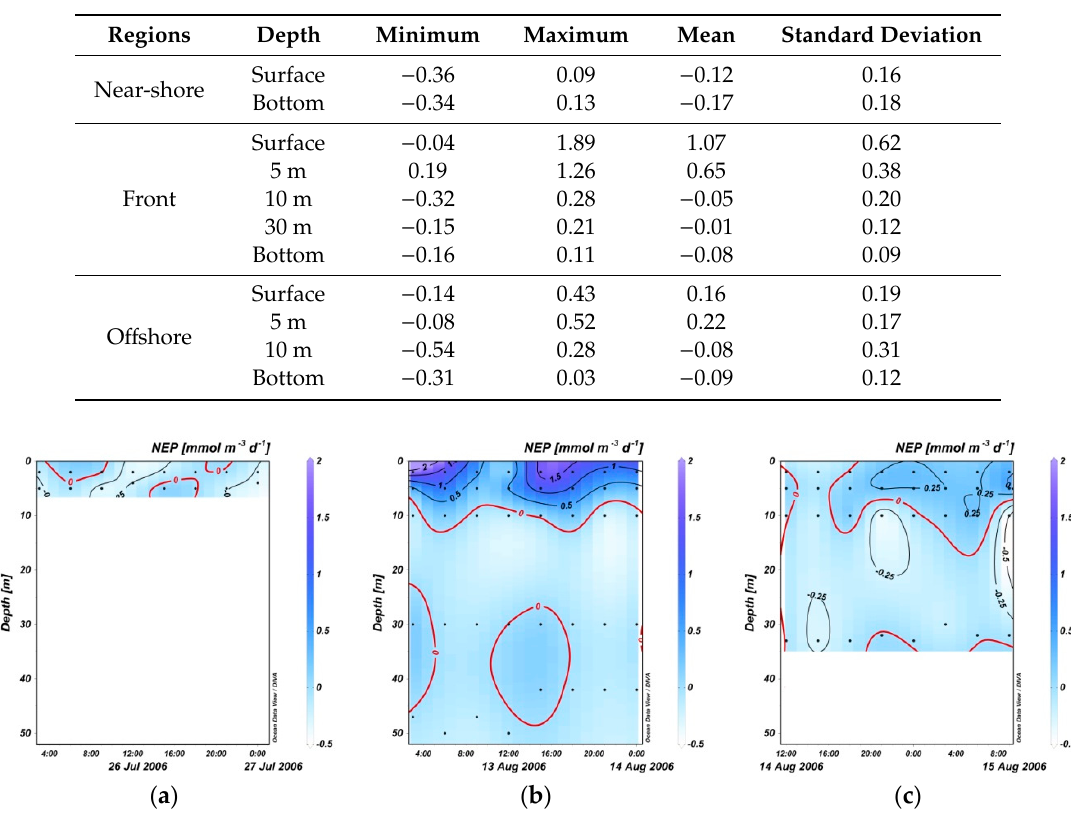
Table 3. Minimum, maximum, mean, and standard deviation of NEP in the three regions in summer (mmol C m − 3 day − 1 ).